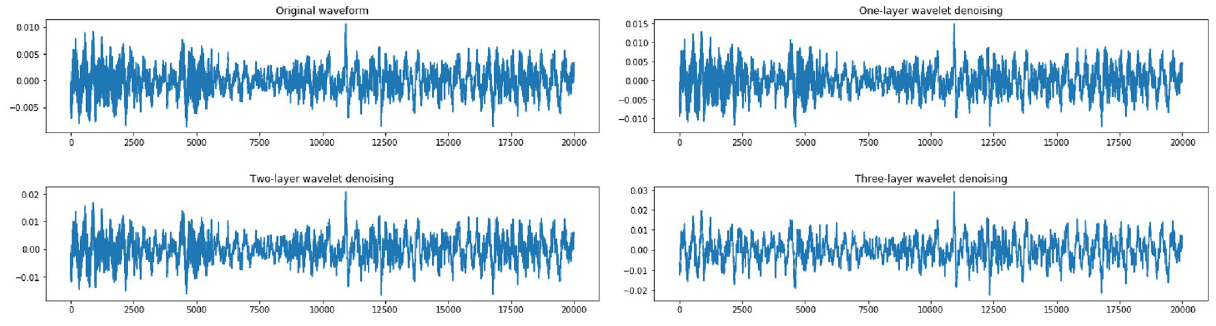
Figure 2. Signal denoising through a three-level Haar-based